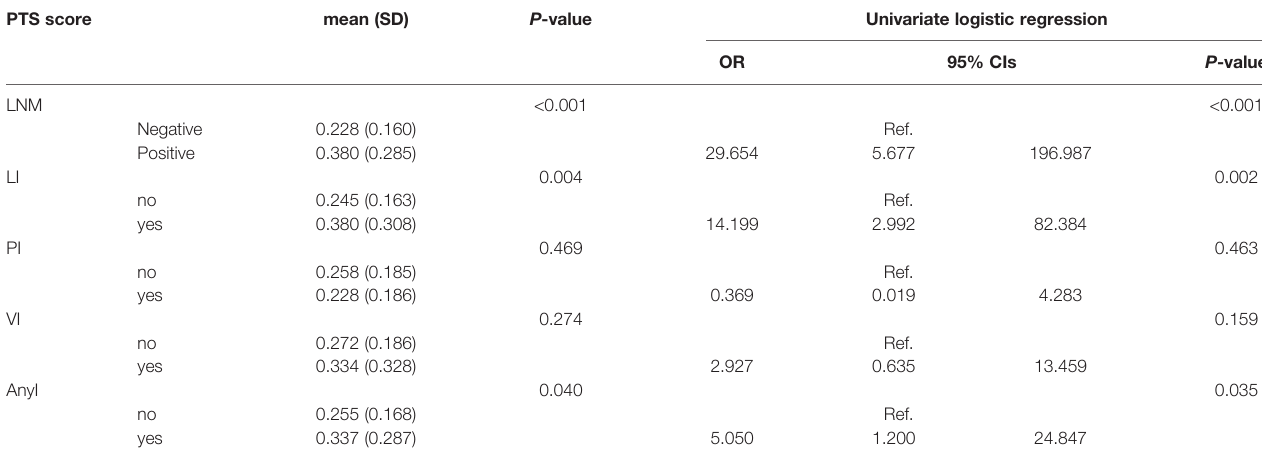
TABLE 3 | Predictive values of the PTS score for metastasis in colon cancer. PTS score